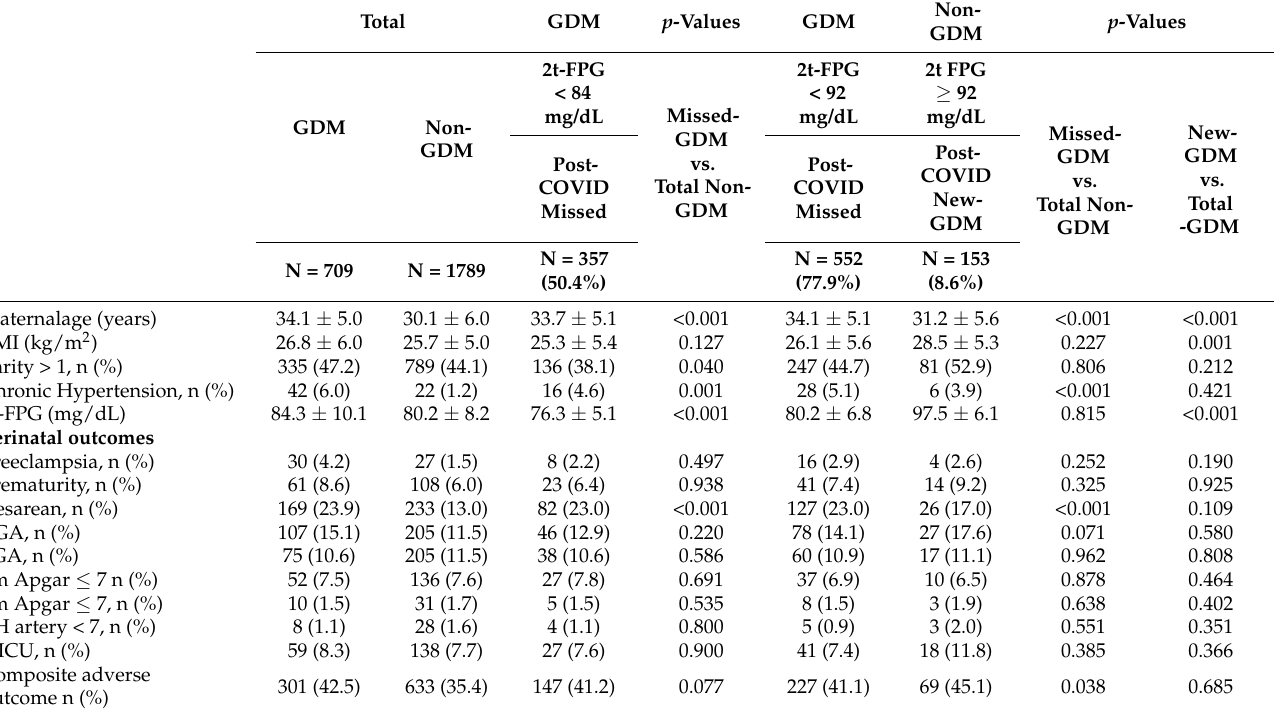
Table 3. Maternal characteristics and perinatal outcomes in pregnant women with gestational diabetes mellitus diagnosed at 24–28 weeks of pregnancy (GM) and with normal glucose tolerance during pregnancy (Non-GDM), according to the two-step diagnosis (18), and in women with post-COVID-19 missed GDM based on the Australia (1) recommendations to rule out the diagnosis of GDM (second trimester fasting plasma glucose (2t-FPG) <84 mg/dL), and perinatal outcomes in pregnant women with missed and new GDM based on the recommendations of Australia (1) and Italy (2) for the direct GDM diagnosis during the COVID-19 pandemic (2t-FPG) ≥ 92 mg/dL. Non- p -Values Total GDM p -Values GDM GDM 2t-FPG < 84 Non- GDM